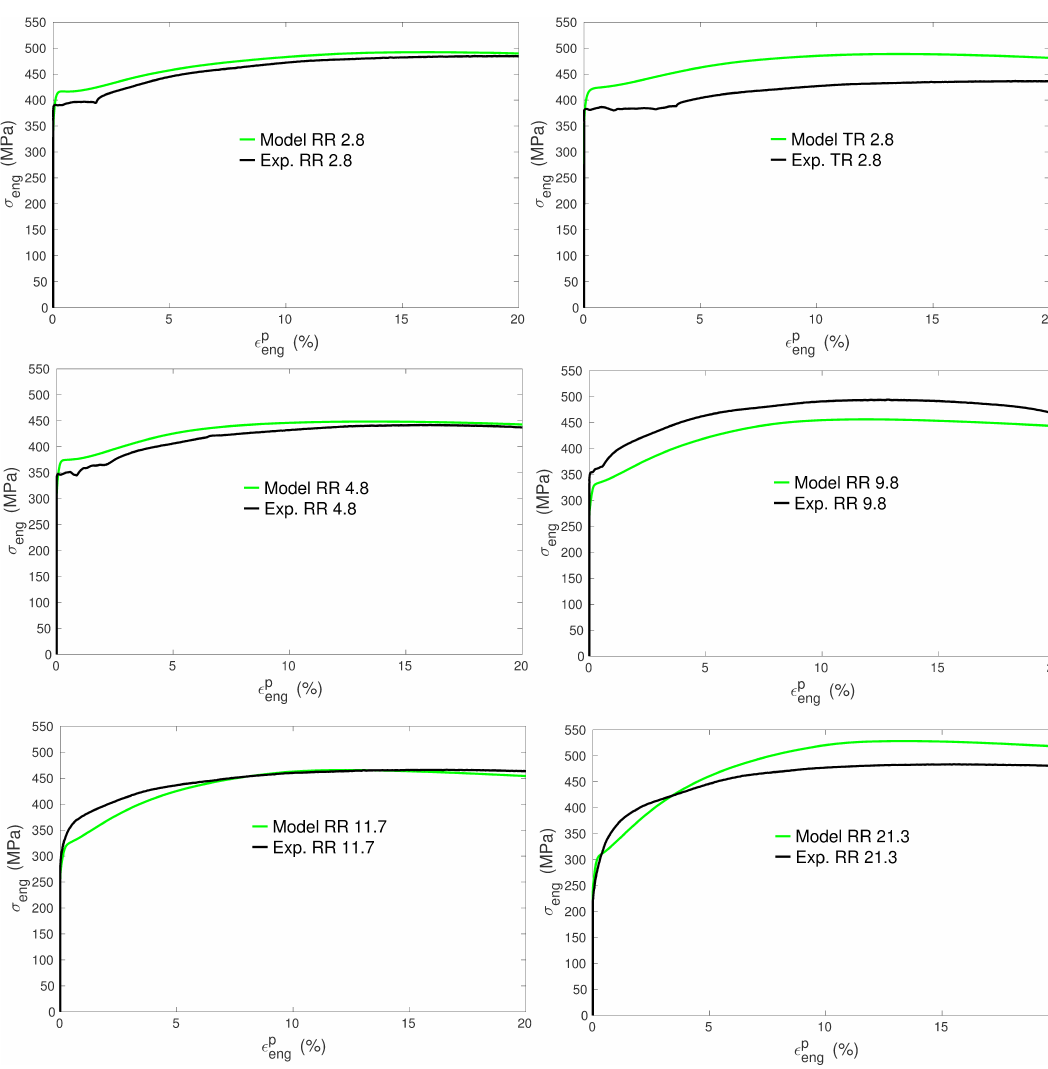
Figure 4. Tensile curves (engineering stress and strain) for model predictions and experimental measurements for the six specimens deformed along the last rolling direction.